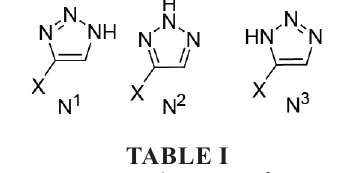
The relative energy of N 1 -H and N 3 -H to N 2 -H in the presence of different